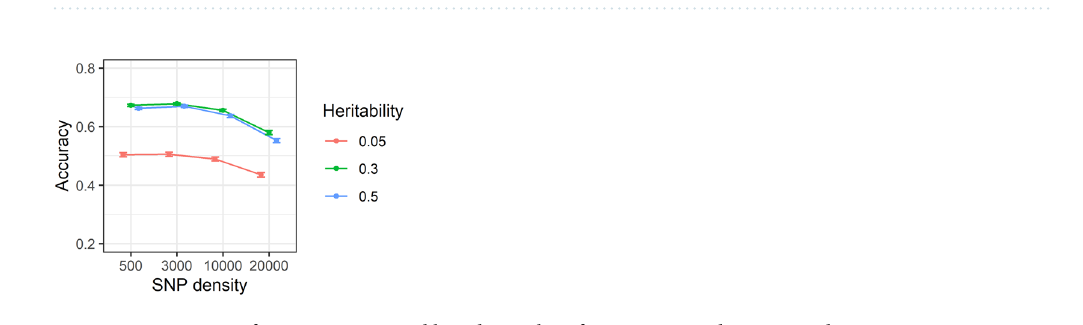
Figure 7. Accuracy of genomic estimated breeding values for genotypic error rates of 0, 1, 5 and 10% over heritabilities of 0.05, 0.3 and 0.5. Correlations are averaged over different generations, replicates, family types and SNP densities. Standard errors of accuracies are shown as error bars.